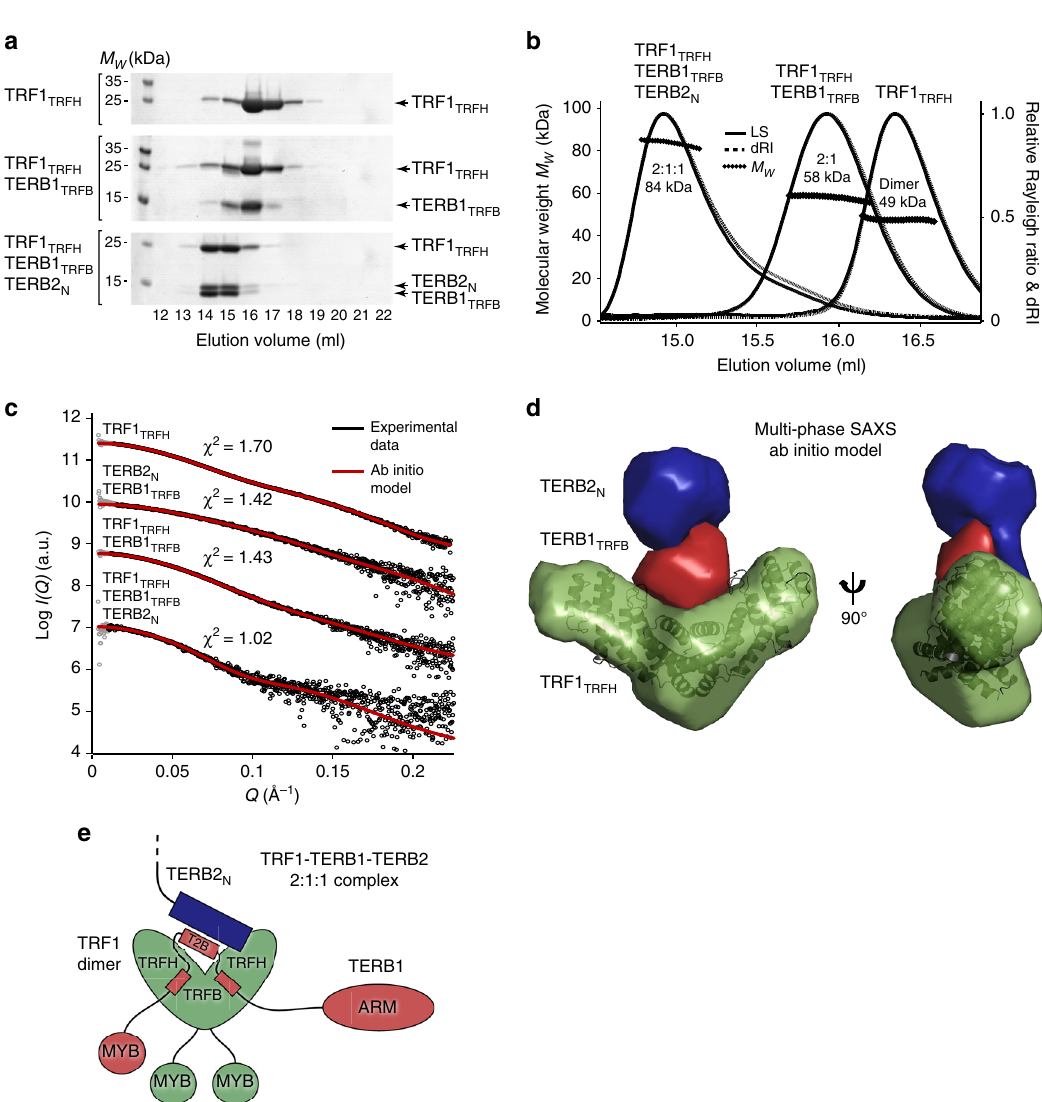
Fig. 6 Structure of the 2:1:1 TRF1 – TERB1-TERB2 complex. a Size-exclusion chromatography elution pro fi les of TRF1 TRFH (62 – 268), TRF1 TRFH -TERB1 TRFB (62 – 268, 561 – 658) and TRF1 TRFH -TERB1 TRFB -TERB2 N (62 – 268, 561 – 658, 1-119). A longer TERB2 N construct of 1-119 was used for size exclusion chromatography and SDS – PAGE to provide molecular weight discrimination from TERB1 TRFB ; all other experiments use a shorter 1 – 107 construct. Source data are provided as a Source Data fi le. b SEC-MALS analysis. TRF1 TRFH is a dimer (49 kDa; theoretical dimer – 48 kDa), TRF1 TRFH -TERB1 TRFB is 2:1 (58 kDa; theoretical 2:1 – 59 kDa) and TRF1 TRFH -TERB1 TRFB -TERB2 N is 2:1:1 (84 kDa; theoretical 2:1:1 – 73 kDa). c , d Multi-phase SAXS ab initio modelling of TRF1 TRFH - TERB1 TRFB -TERB2 N using MONSA in which experimental data of the complex and its constituents were used to fi t their ab initio structures and relative orientations within the full complex. c SAXS scattering data of TRF1 TRFH , TERB2 N -TERB1 TRFB , TRF1 TRFH -TERB1 TRFB and TRF1 TRFH -TERB1 TRFB -TERB2 N overlaid with the theoretical scattering curves of their modelled structures (red; χ 2 values of 1.70, 1.42, 1.43 and 1.02, respectively). The scattering data points below the minimum Q-value of the Guinier analysis are shown in grey. d Multi-phase SAXS model of TRF1 TRFH -TERB1 TRFB -TERB2 N in which TRF1 TRFH is shown in green with its known crystal structure superposed (PDB accession 5WIR 45 ), and TERB1 TRFB and TERB2 N are shown in red and blue, respectively. e Model of the 2:1:1 TRF1 – TERB1 – TERB2 complex. The dimeric cleft of the TRF1 TRFH domains interacts with TERB1 through the TRFB region that includes its binding site for the globular N-terminus of TERB2. Source Preparation of a MAJIN – TERB2 selenomethionine derivative . Transformed Recombinant expression and puri fi cation of full length TRF1 . TRF1 (1 – 439) was BL21 (DE3) E. coli were cultured in 2xYT media (Formedium), harvested at an expressed as described above, and cell lysis was performed in 20 mM Tris pH 8.0, OD 600 of 0.6 and washed in 150mM NaCl before being transferred to M9 500 mM KCl, 10% glycerol. Ni-NTA (Qiagen) af fi nity and HiTrap Q HP (GE Healthcare) ion exchange chromatography were performed using the same buffer, media (Formedium) supplemented with trace elements (2.5mgl − 1 CoCl 2 .6H 2 O, 15 the latter with a salt gradient between 0.1 – 1.0M KCl. TEV protease was added at a 1:15 ratio and incubated overnight at room temperature. Cleaved TRF1 was further puri fi ed through HiTrap Q HP ion exchange chromatography (salt gradient 0.1 – 1.0M KCl) and size exclusion chromatography (HiLoad ™ 16/600 Superdex 200, GE Healthcare) in 20mM Tris pH 8.0, 250mM KCl, 10% glycerol buffer, 2mM DTT. TRF1 was concentrated to a fi nal concentration of 15mg ml − 1 using Microsep ™ Advance Centrifugal Devices 10,000 MWCO centrifugal fi lter units (PALL) at room temperature and stored at − 80°C following fl ash-freezing in described for the native protein. liquid nitrogen.